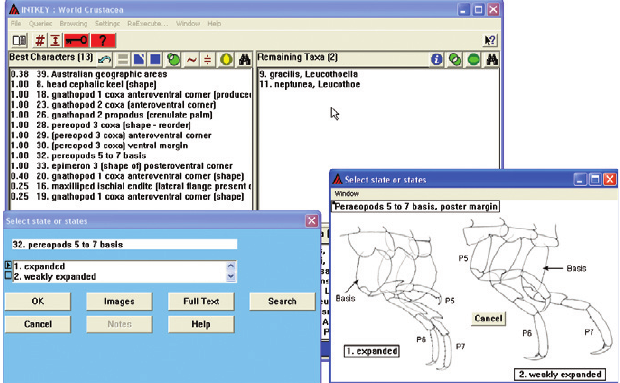
Figure 74. Clicking on the Images button during the selection of character states will show the illustra- tions for all character